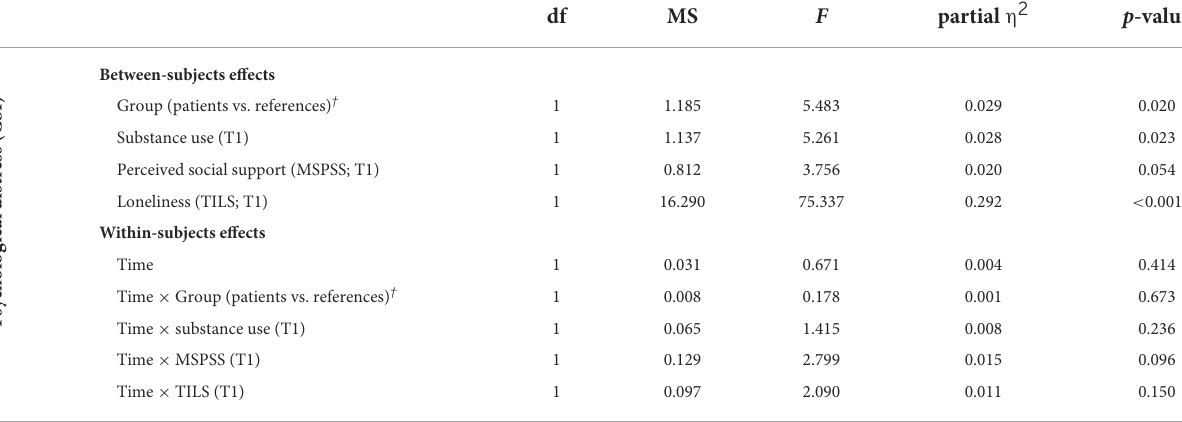
TABLE 4 Effect of substance use, perceived social support, and loneliness on psychological distress in patient and reference group—findings of repeated measures ANCOVA (z-standardized). df MS F partial η